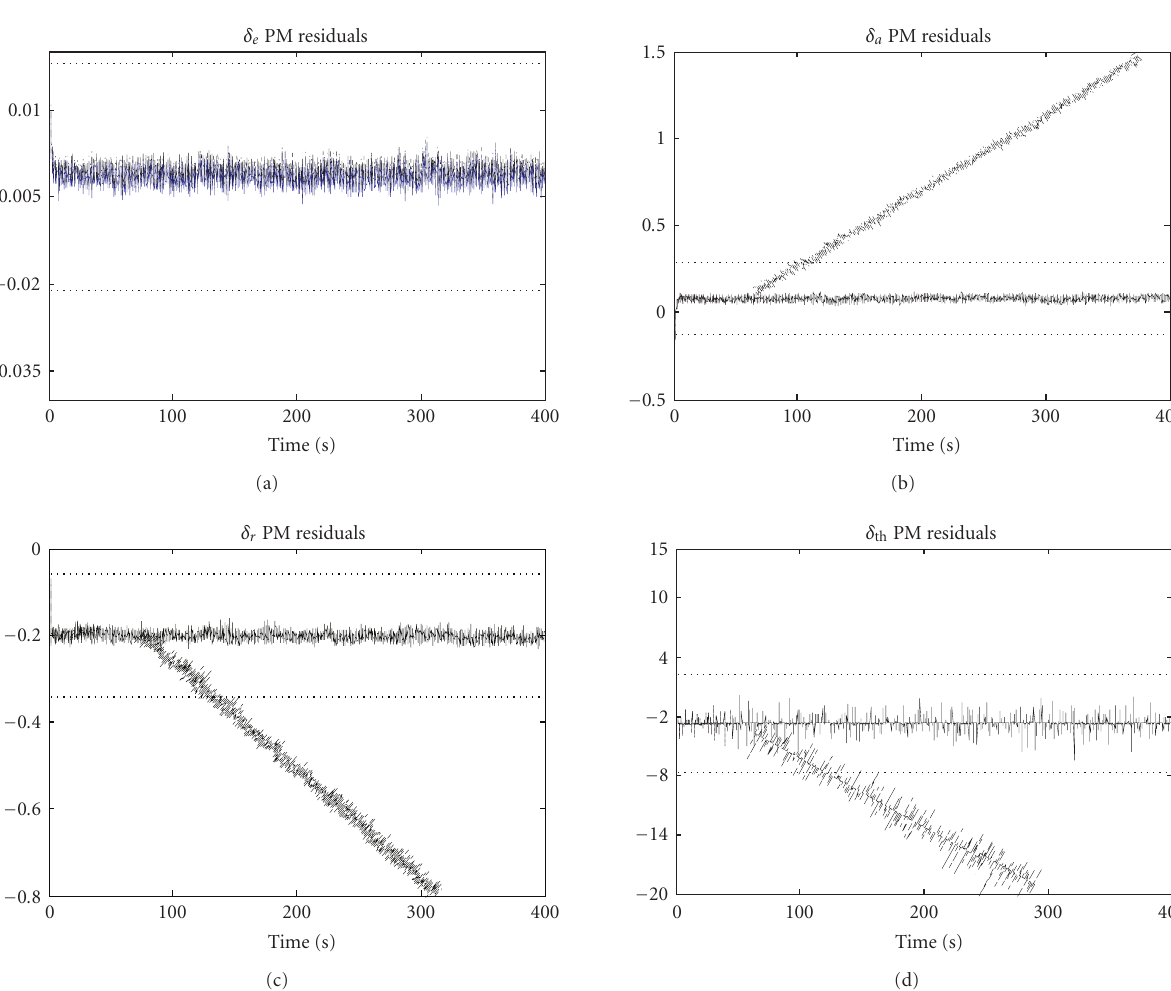
( t ) isolation with ν = 1